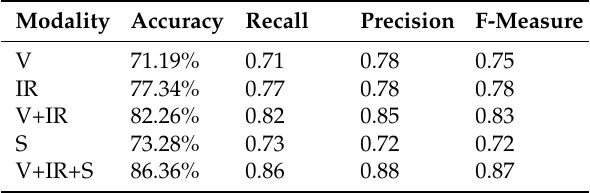
Table 3. Comparison of the AER metrics by different modalities (Visible: V, Infrared: IR, Speech: S). Modality Accuracy